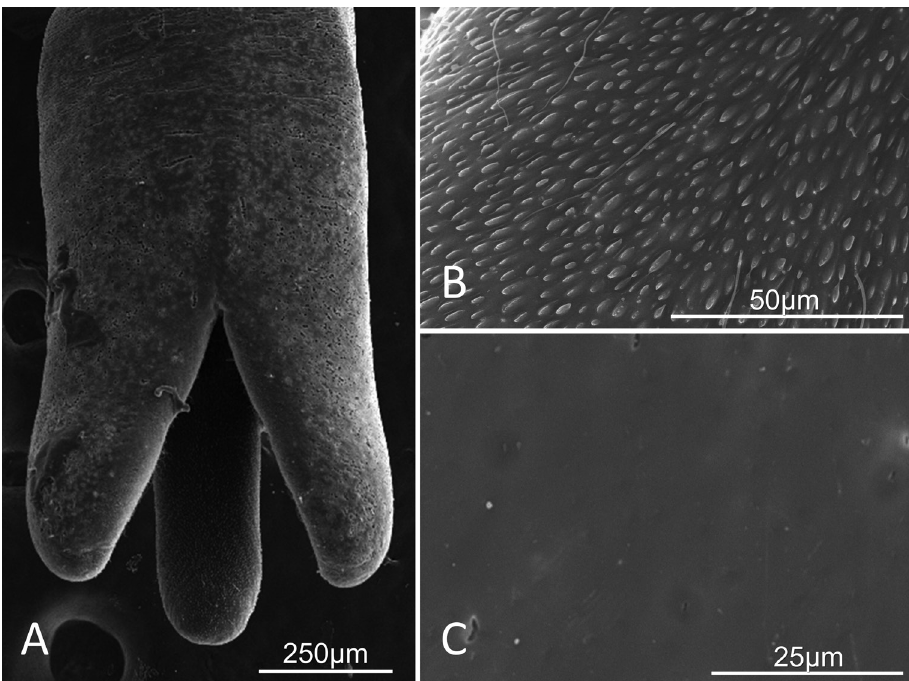
Figure 3. Paragordius amicus sp. n. adult female from the Huachuca Mountains A Trifurcating posterior. B High magnification view of the oblong mounds and long, thin hair extensions found on the interior surface of the trifurcating lobes C Midbody cuticle lacking obvious surface